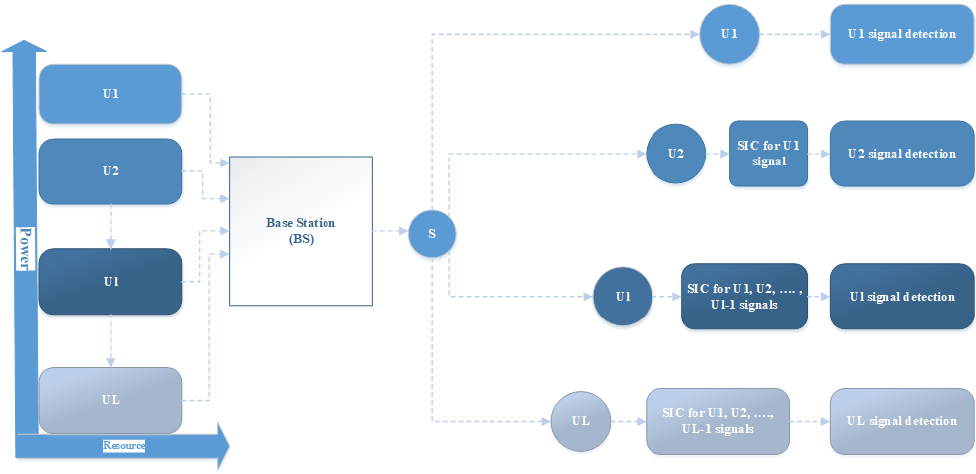
Figure 5. Downlink sub-channel system model of